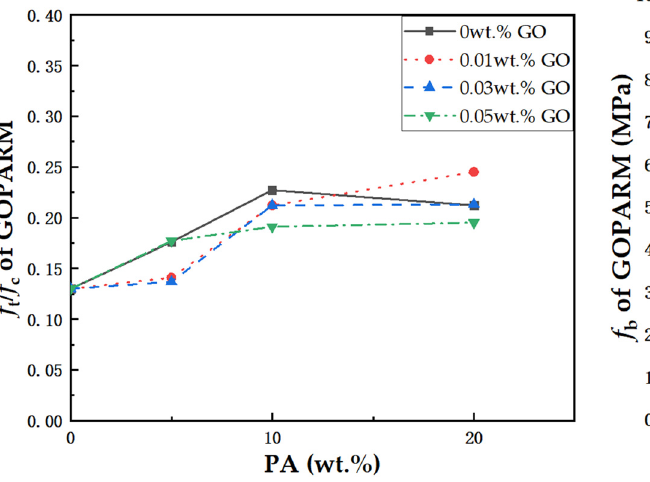
Figure 6: 7 days f b change in GOPARMs along with di ff erent PA and GO